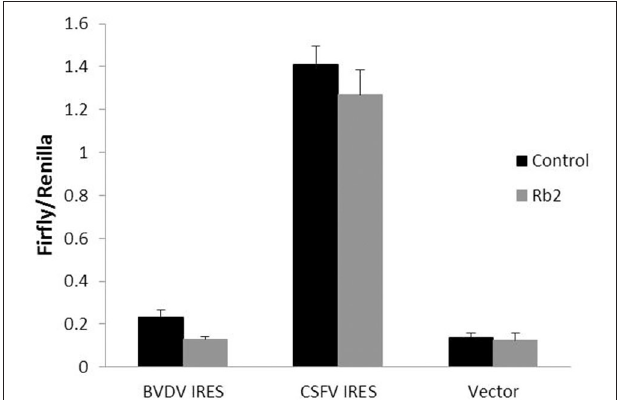
FIGURE 9 | The effect of Rb2 on the activity of IRES of BVDV and CSFV with dual-Luciferase assay. ** p < 0.01.